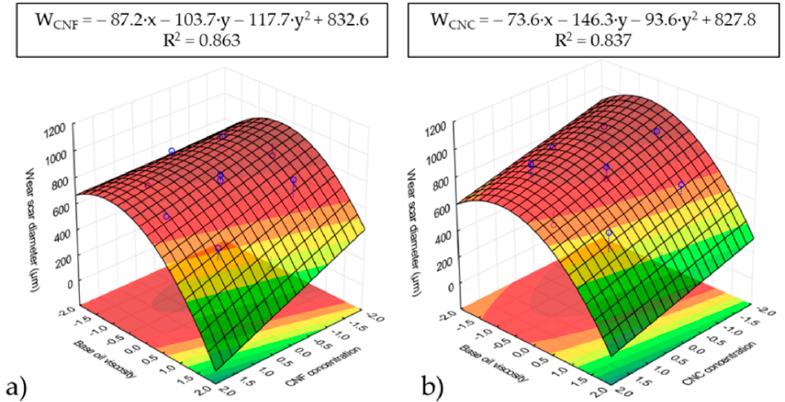
Figure 7. Response surface analysis (RSM) based on wear scar diameters for CNF ( a ) and CNC ( b ) ecolubricants.